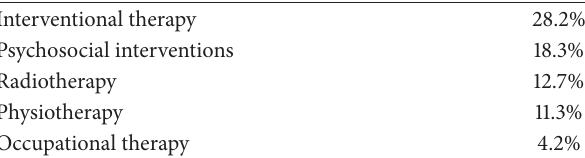
Table 5: Analgesics drugs offered at the Cancer Pain Clinic.